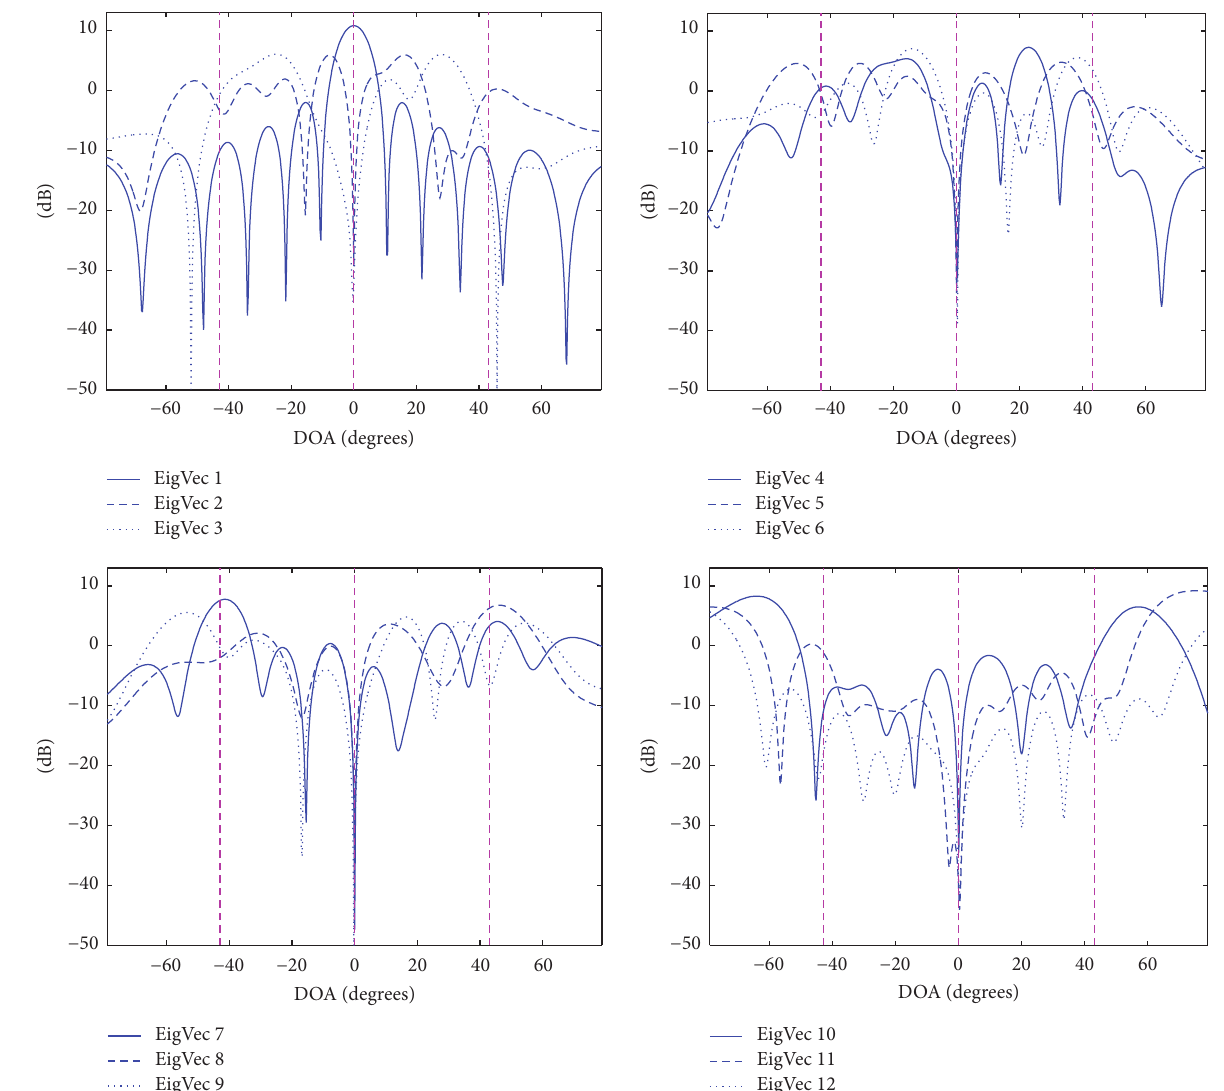
Figure16:EigenpatternsformeasurementC1W(asingleweaktransmitter).1SM.DashedverticallinesarethetrueDOAsofthetransmitter(s) and the nearest left and right corner of the reflector. Figure 6.20 in